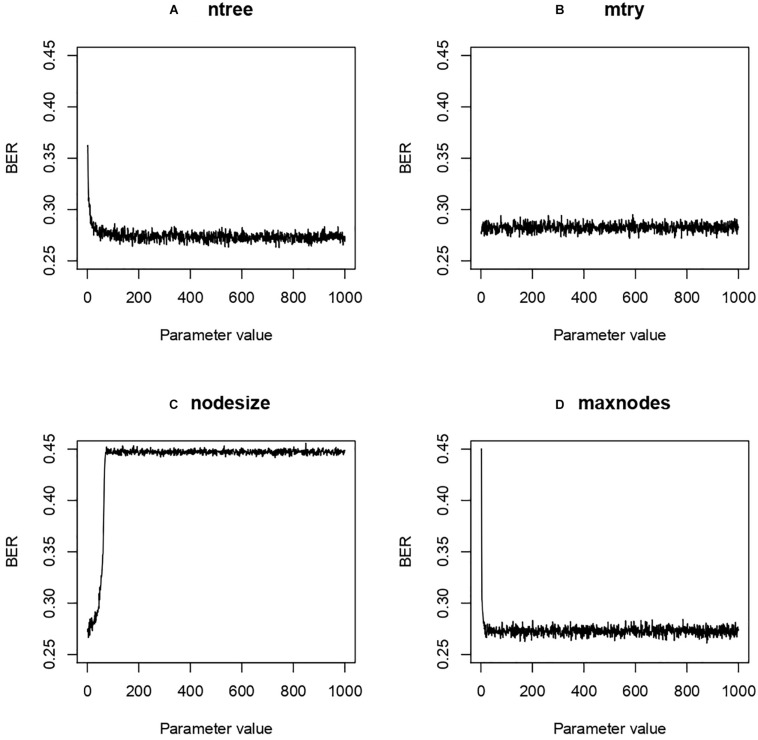
Balanced Error Rate (BER) evolution according to modulation of Random Forest (RF) parameters. Four different RF hyper-parameters were tested while keeping the others at default value in a grid search approach. The results were then used in an Irace search to find optimal parameters. (A) ntree, number of decision trees; (B) mtry, number of variables selected from a decision split for the next split; (C) maxnodes, maximal number of nodes; (D) nodesize, minimal number of samples allowed in a node.